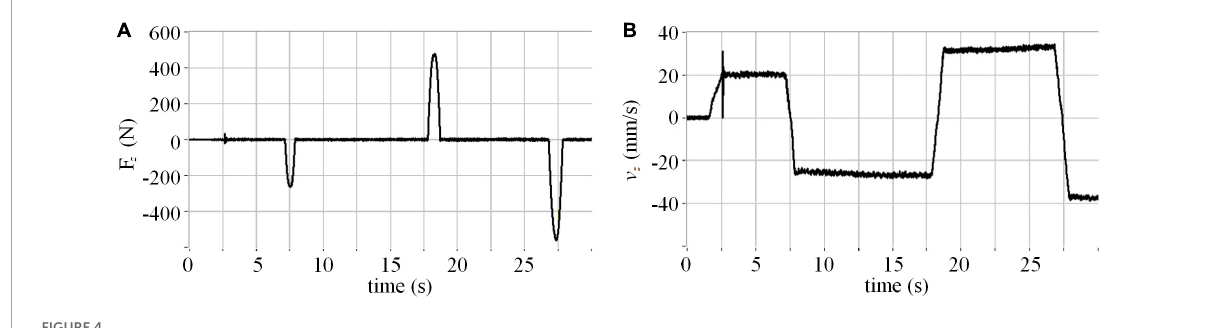
FIGURE4 Rod test results: (A) Force; (B)